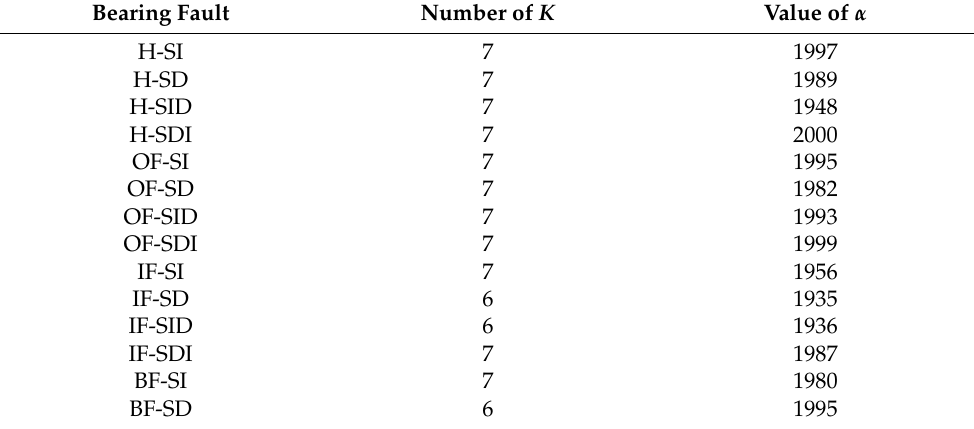
Table 2. Results of